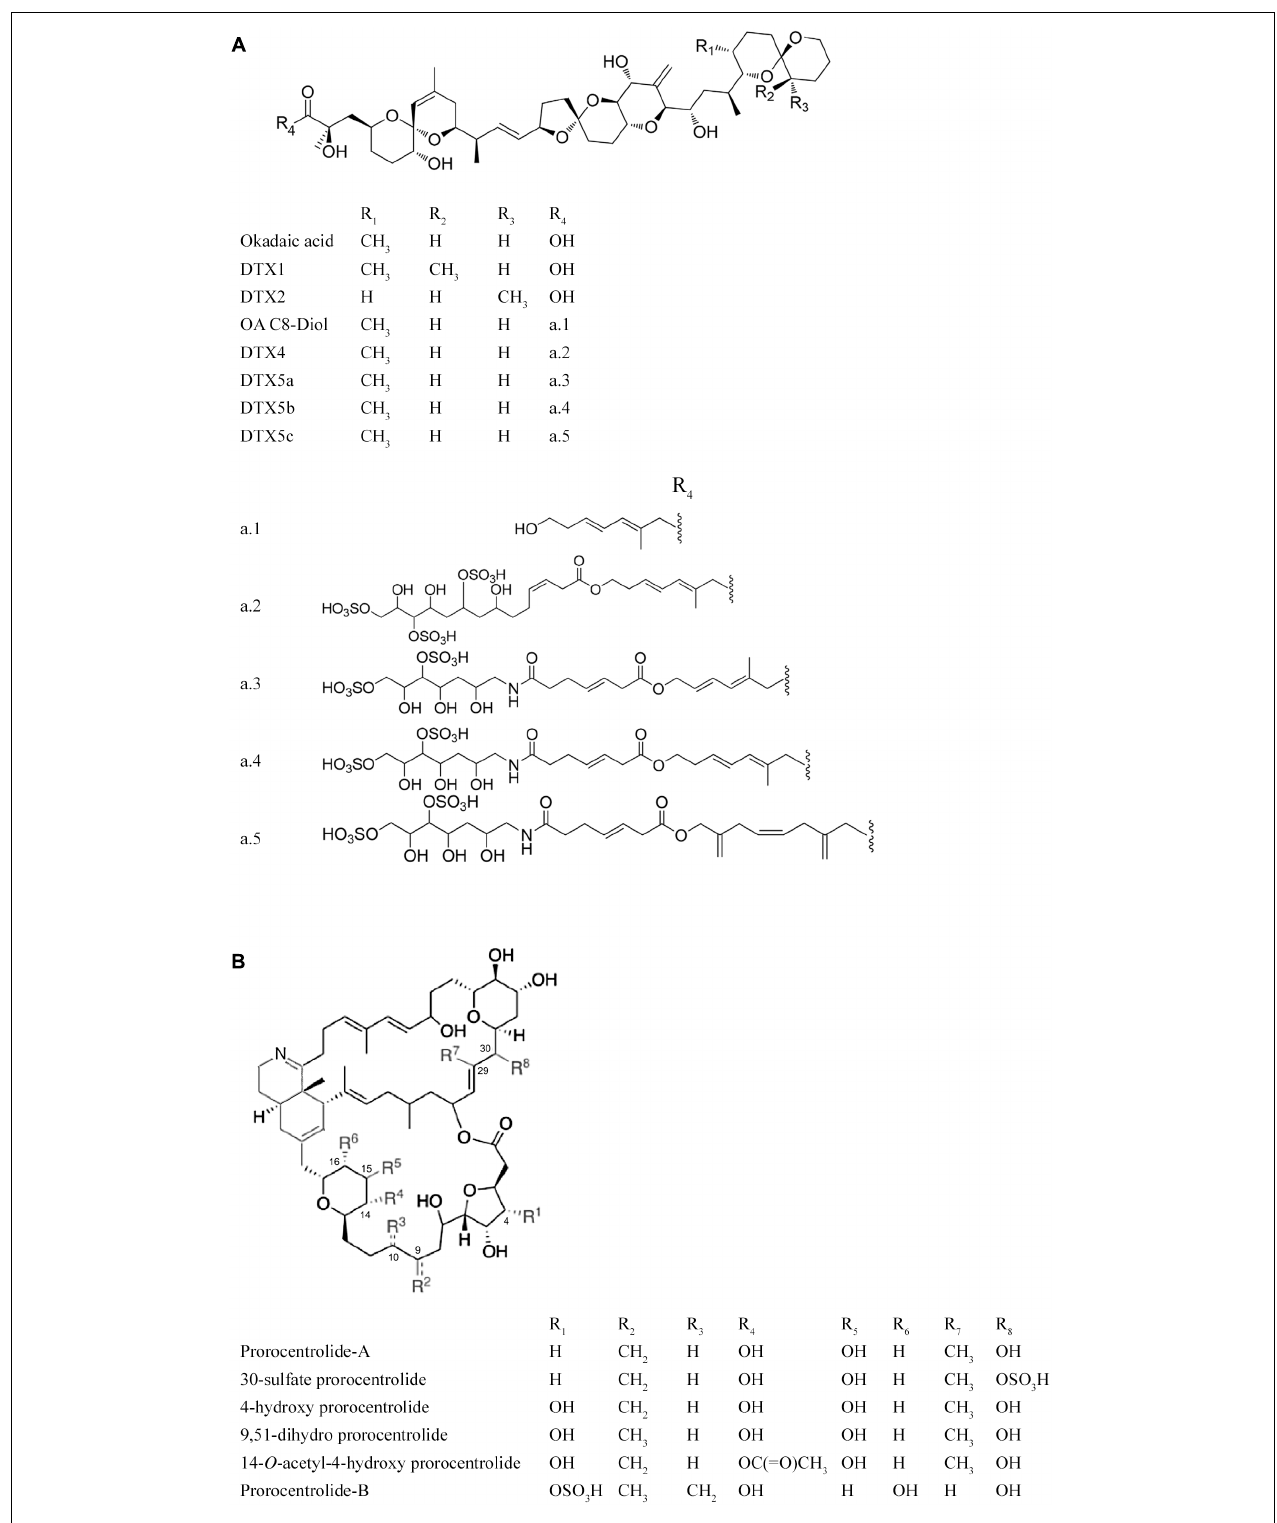
FIGURE 3 | (A) Okadaic acid (OA) and dinophysistoxins (DTXs) produced by benthic members of the genus Prorocentrum (Twiner et al., 2016); a.1 to a.5 C8-diol ester and sulfated diesters of OA. (B) Prorocentrolides and analogs reported to date. Modified from Amar et al. (2018).